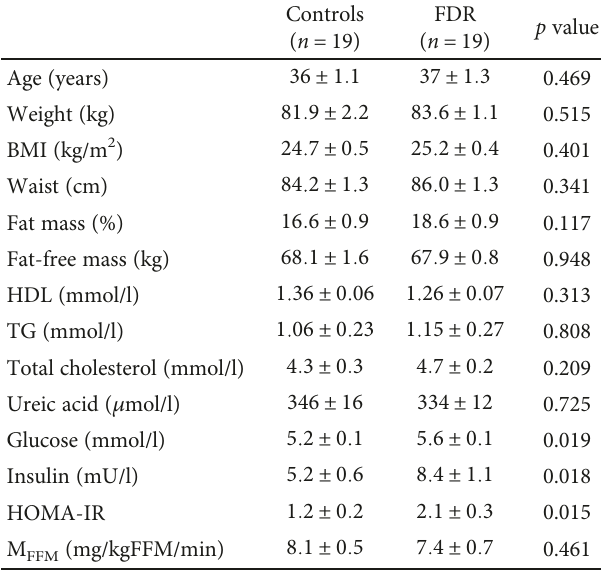
Table 1: The anthropometrical and biochemical parameters of the 2 groups of subjects.